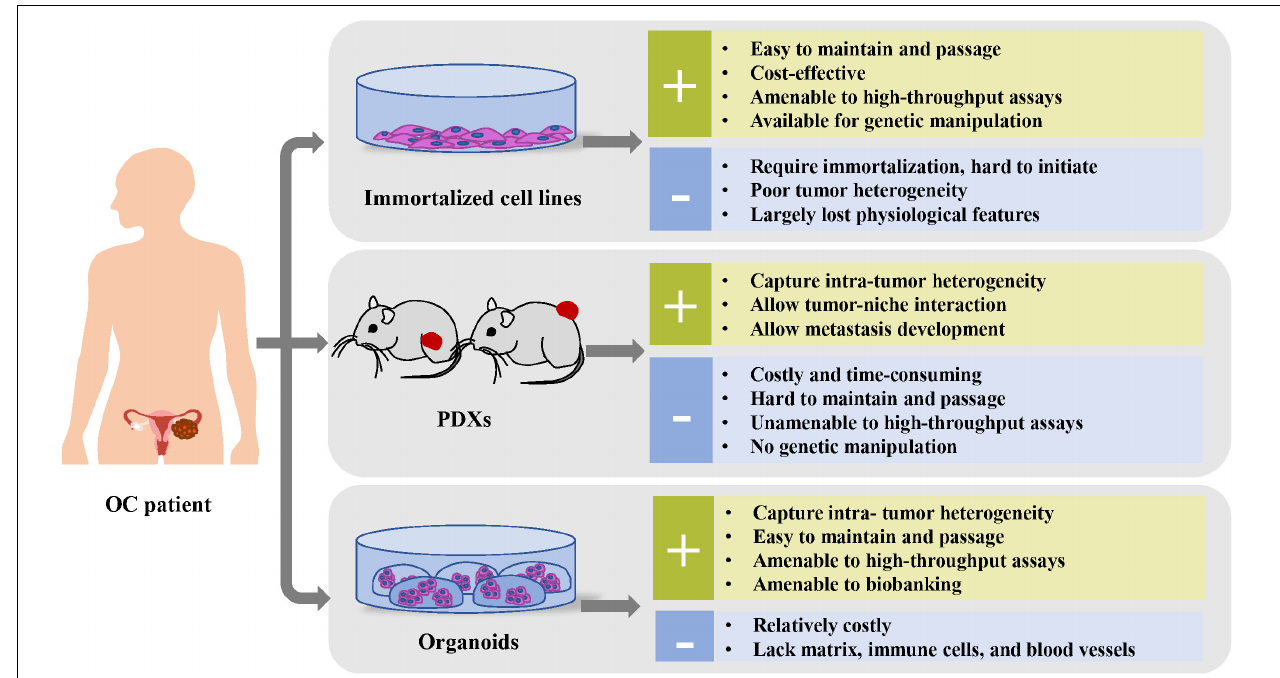
FIGURE 1 | Comparison of the advantages and disadvantages of preclinical cancer models, including immortalized cell lines, PDXs, and